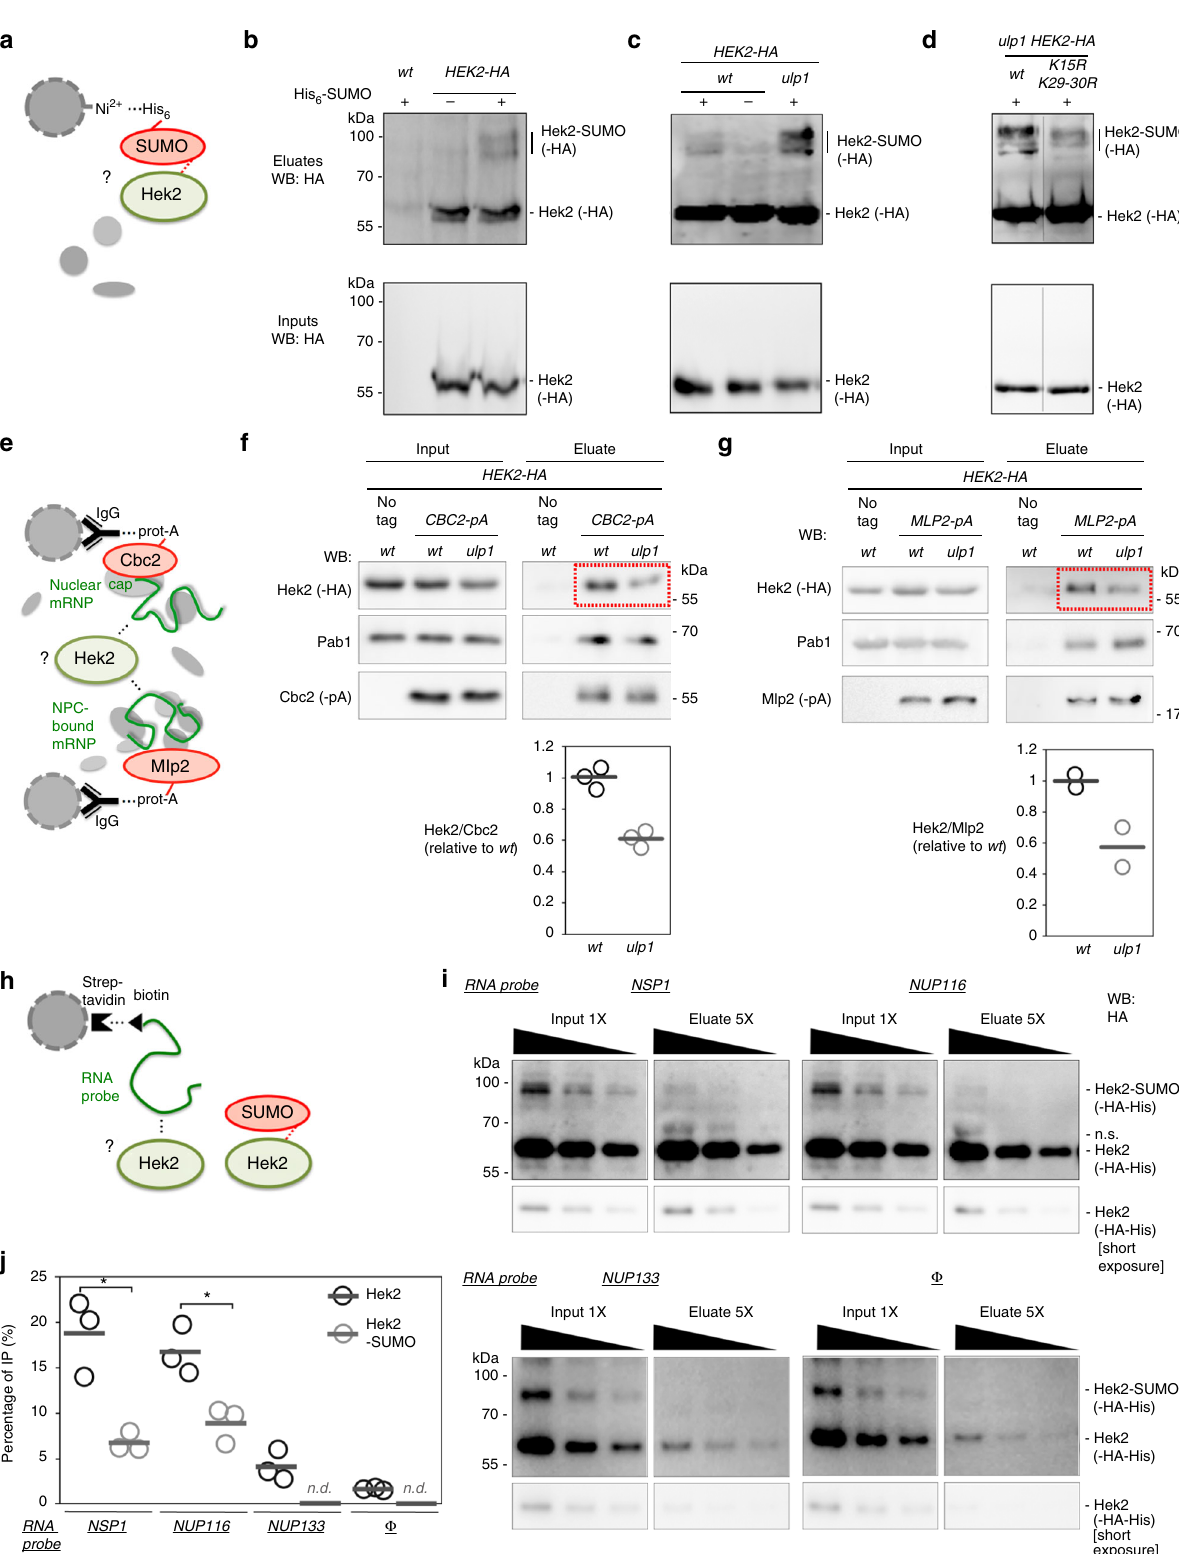
similarly target cytoplasm-localized NPC mRNPs (Fig. 2b). In view of the functional relationships between sumoylation and NPCs 11 and of the multiple examples of nucleic acid-binding proteins whose activity is controlled by SUMO 32 , we rather wondered whether Hek2 could be regulated by this modi fi cation.